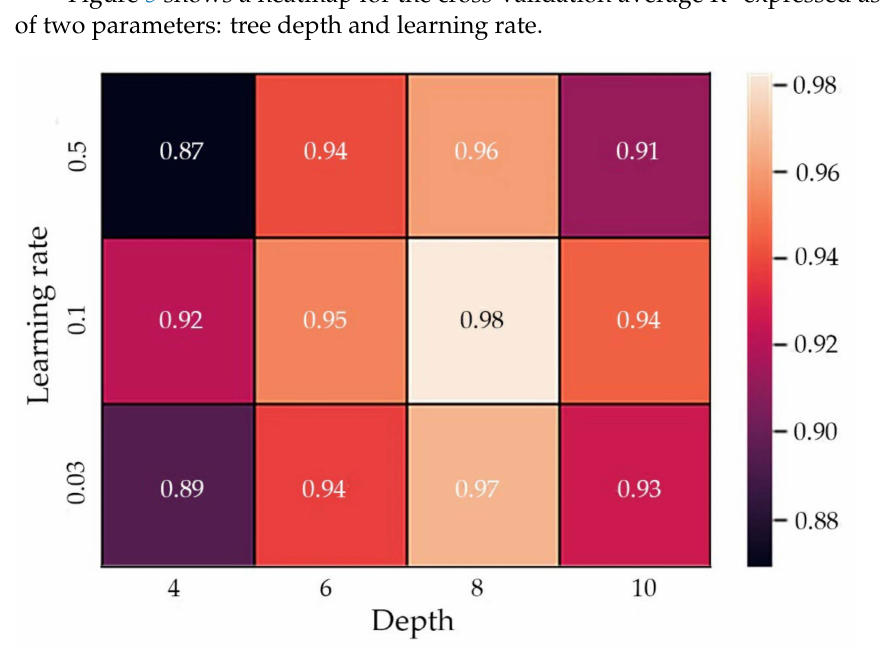
Figure 5. Heat map of R 2 value from two parameters: tree depth and learning rate. Each heatmap value corresponds to an R 2 value for a specific combination of parame- ters, where light tones correspond to a high value and dark tones to a low value. It can be seen from the graph that the implemented CatBoost algorithm is sensitive to parameter settings, so their optimization is necessary to obtain good generalization ability. Various combinations of learning rates and tree depths increase R 2 from 87% (learning rate 0.5, tree depth 4) to 98% (learning rate 0.1, tree depth